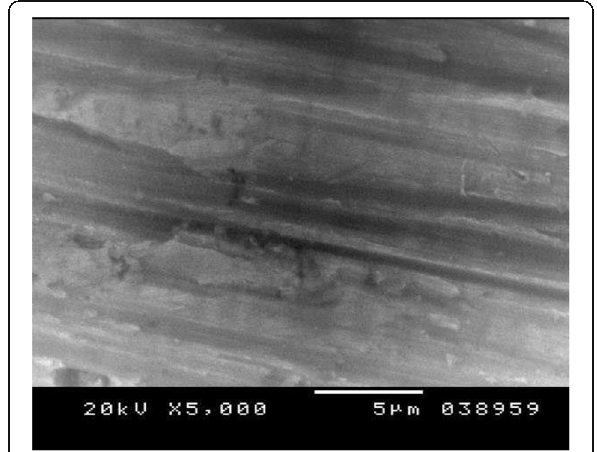
Fig. 7 Scanning electron microphotograph of control Cp Titanium specimen at X 5,000